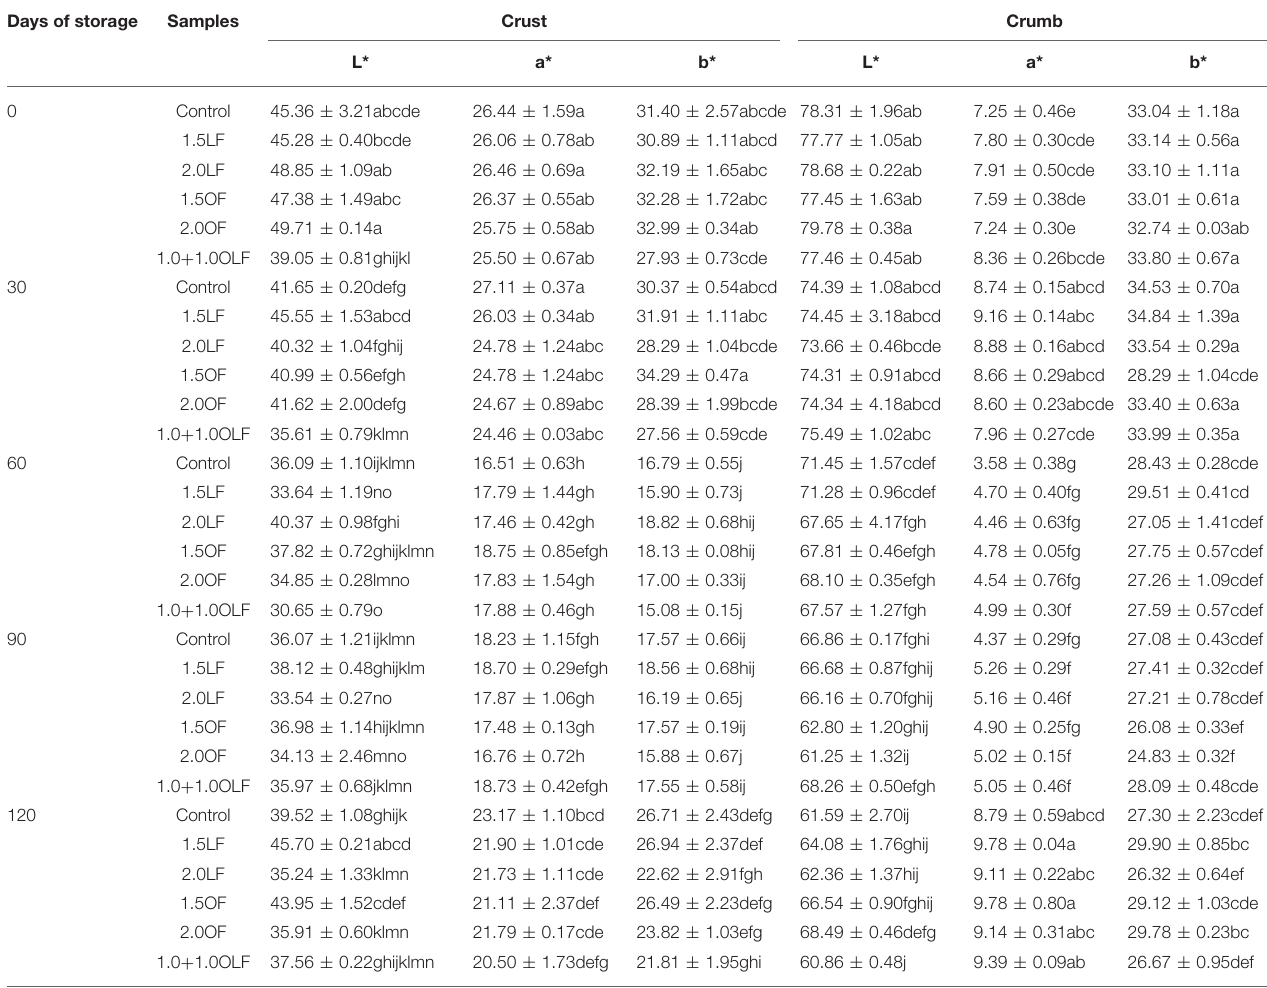
TABLE 7 | Color parameters of breads produced using various doses of blood orange and lemon citrus fibers. Days of storage